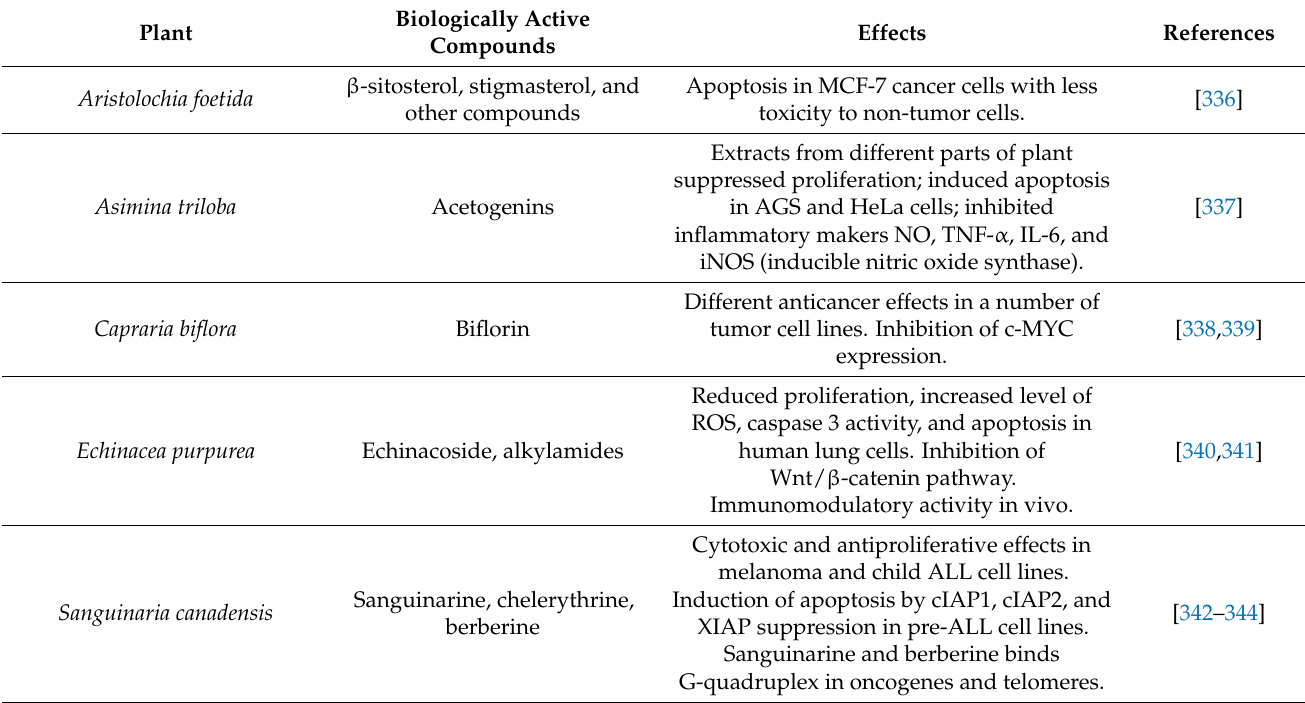
Table 5. Some others North American plants and their compounds with anti-neoplastic activity. Biologically Active Plant Compounds